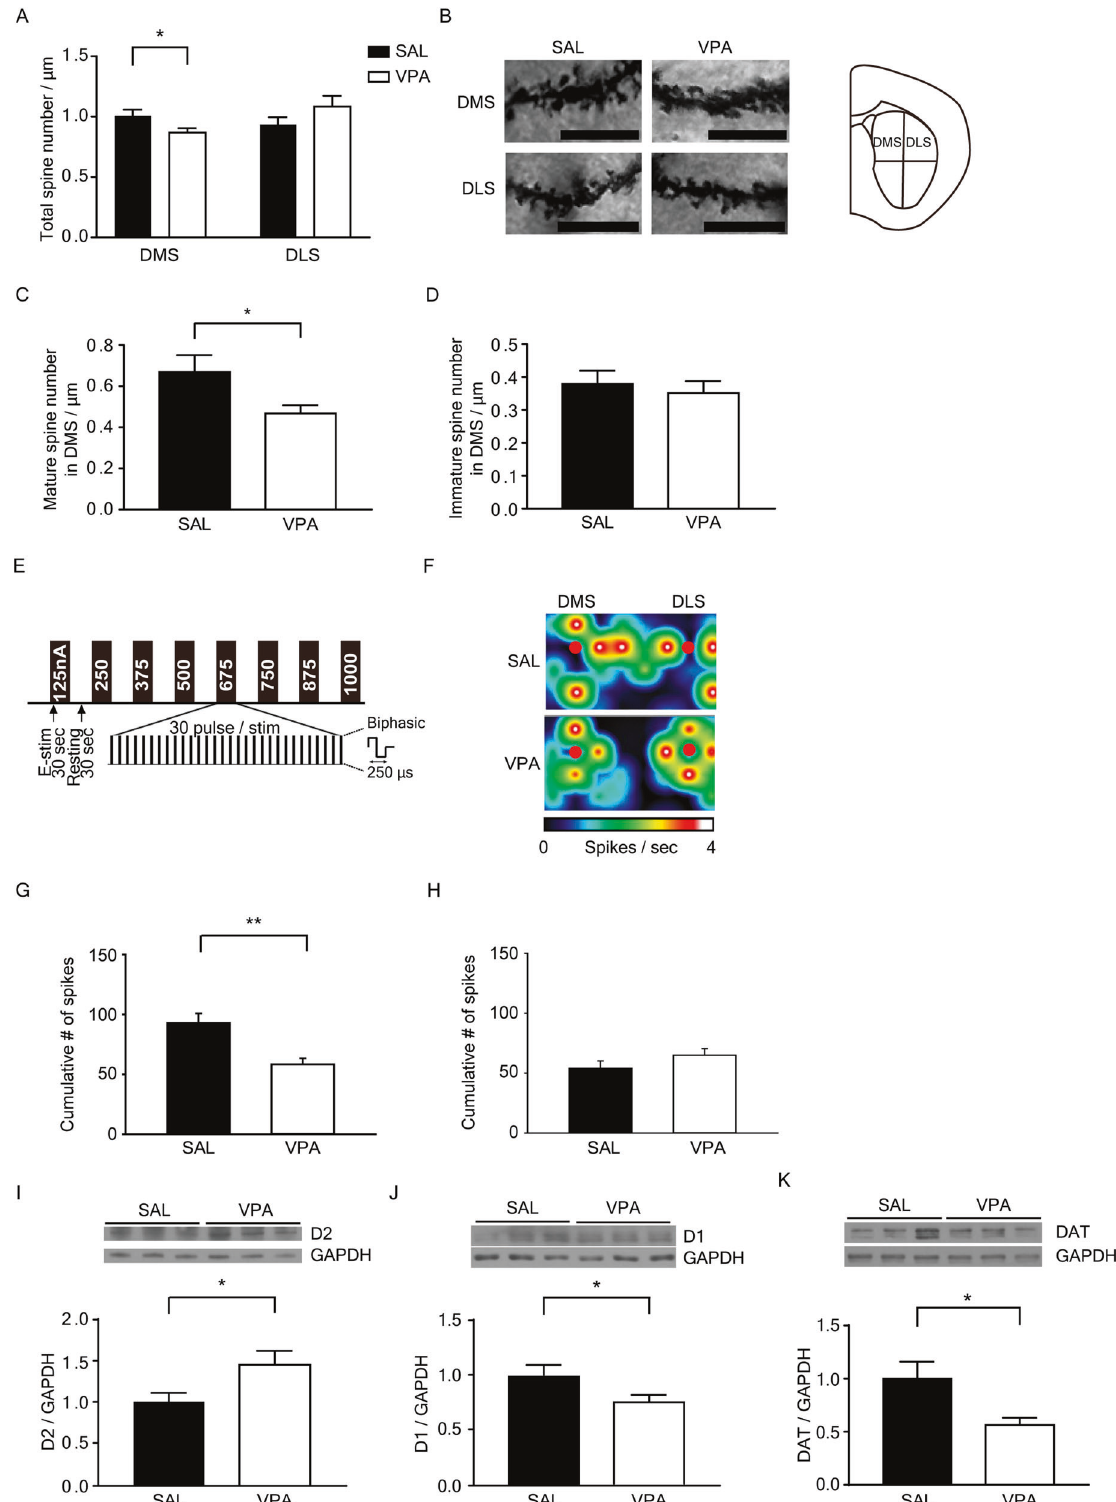
phenotype ( “ exostosis ” , “ abnormal ischium morphology ” , and “ abnormal pubis morphology ” ) (Fig. 2C, D). Because the upregulated gene sets exhibited more relevance to neuronal function and ASD symptoms than the downregulated gene sets, we speci fi cally focused on the upregulated